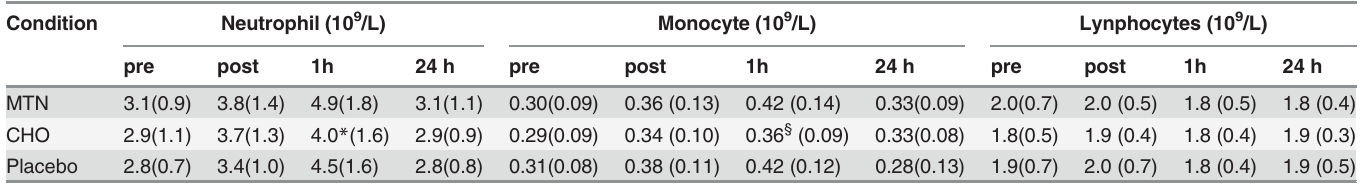
Table 4. General markers of immunity determined at before (pre), immediately after (post), and 1 h (1h) and 24 h (24h) after intermittent repeated sprint test. Condition Neutrophil (10 9 /L) Monocyte (10 9 /L) Lynphocytes (10 9 /L)